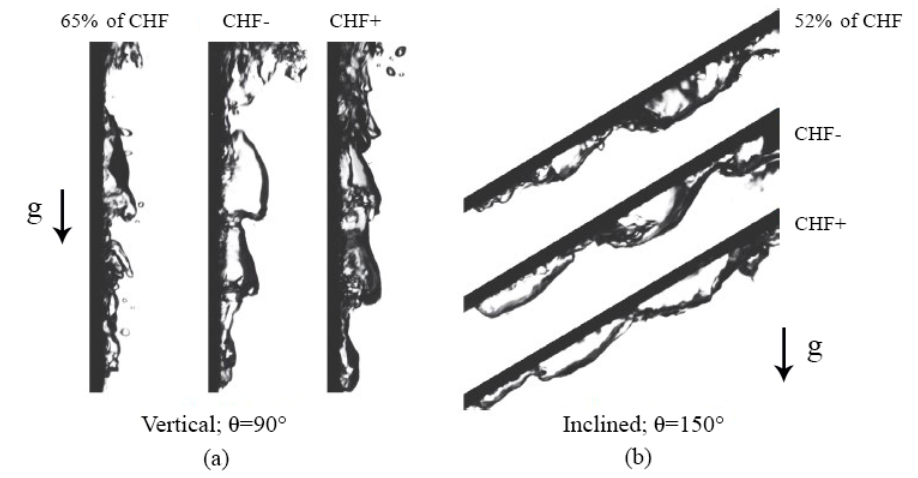
Figure 17. Pool boiling photographs for ameliorating heat flux at diverse surface orientations of ( a ) θ = 90 ◦ and ( b ) θ = 150 ◦ . Adapted from Howard and Mudawar. Reproduced from [265], Elsevier: